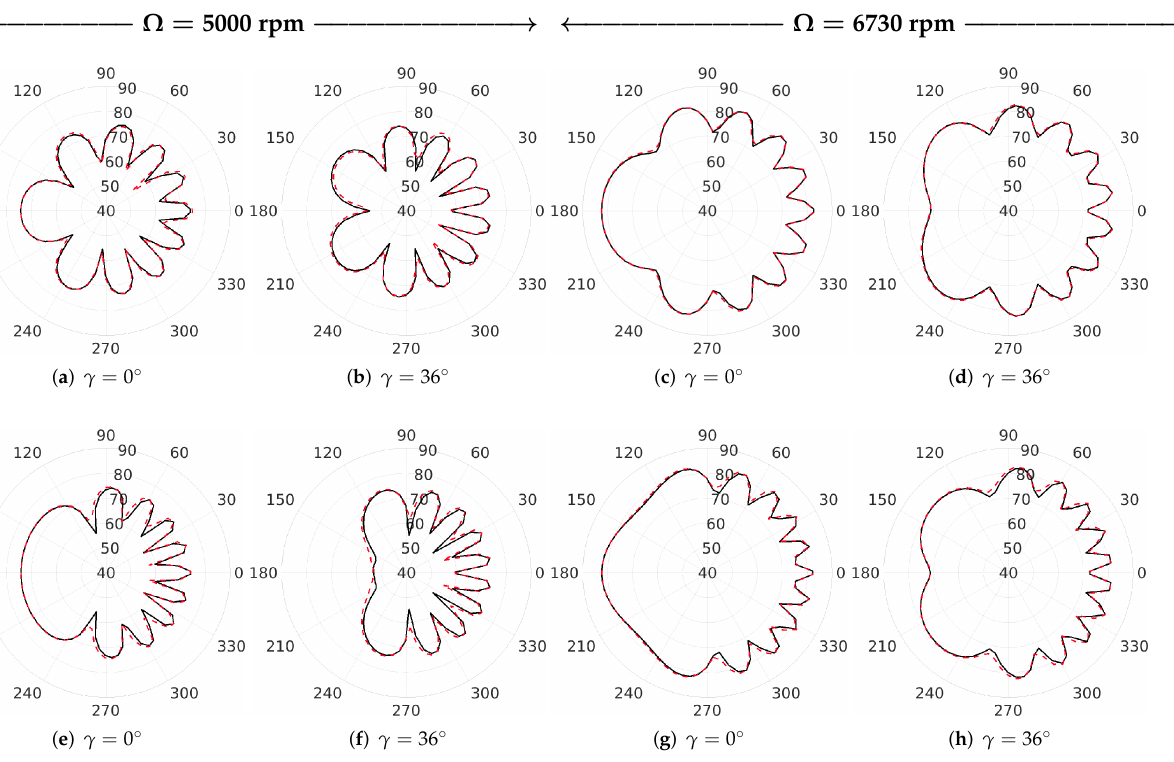
Figure 10. Counter-rotating configuration, comparison between far-field and near-field OASPL directivity patterns; red line near field, black line far-field; TC = 0.05 d (upper), TC = d